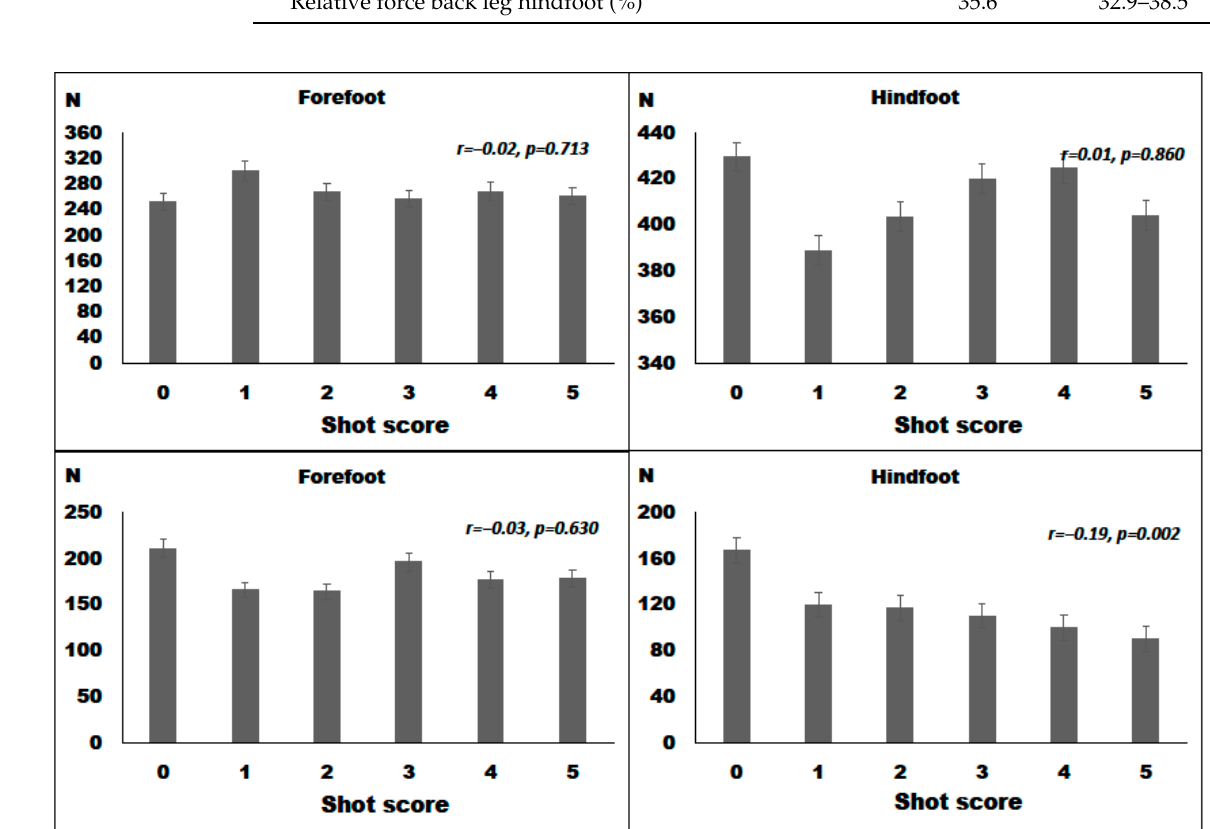
Figure 3. The associations between absolute ground reaction forces beneath the forefoot and hind ‐ foot region of both feet with shot score in the study